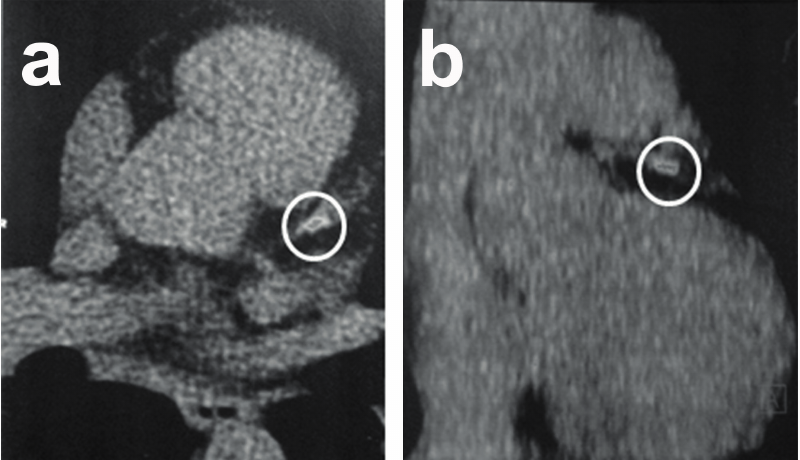
Figure 2 - Tomographic images of the coronary arteries of the participant with